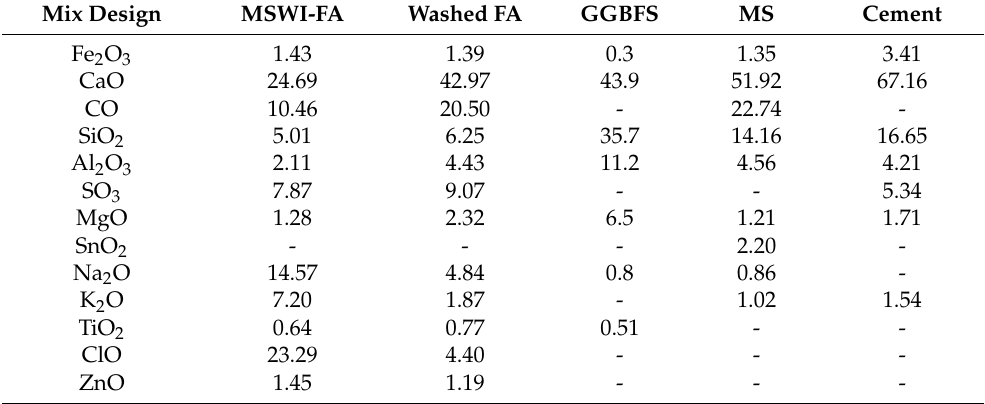
Table 1. Chemical compositions of the materials used for the production of aggregates (wt %).